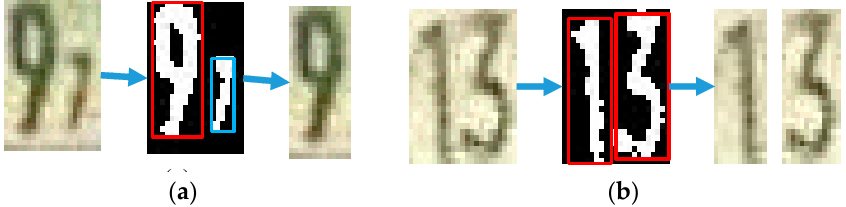
Figure 15. Digit object determination: ( a ) Elimination of mini digits and ( b ) division of closed digits.